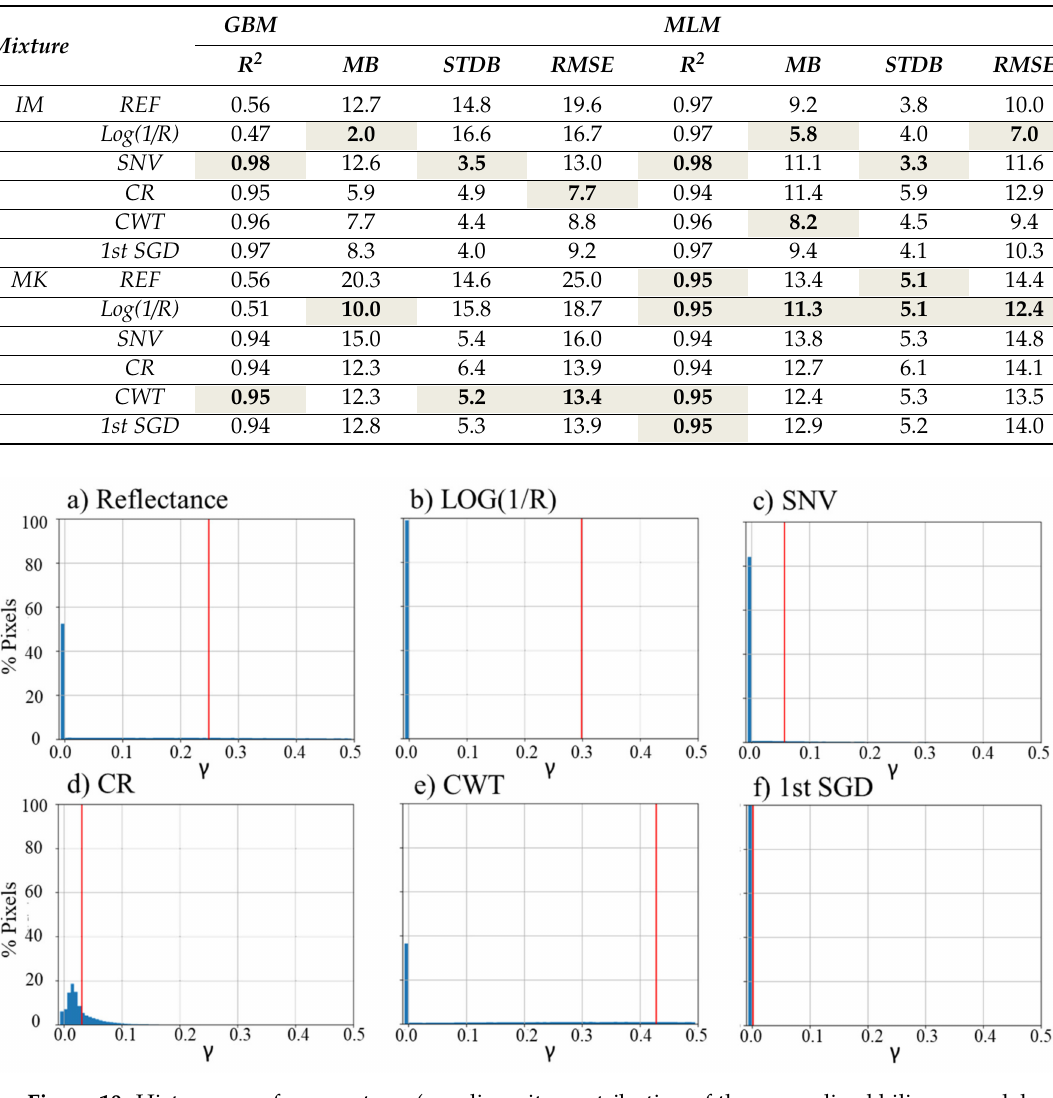
Table 7. Performances of non-linear unmixing methods to estimate montmorillonite abundances for IM and MK intimate mixtures with di ff erent combinations of spectral preprocessings (best results in grey cells bold font).